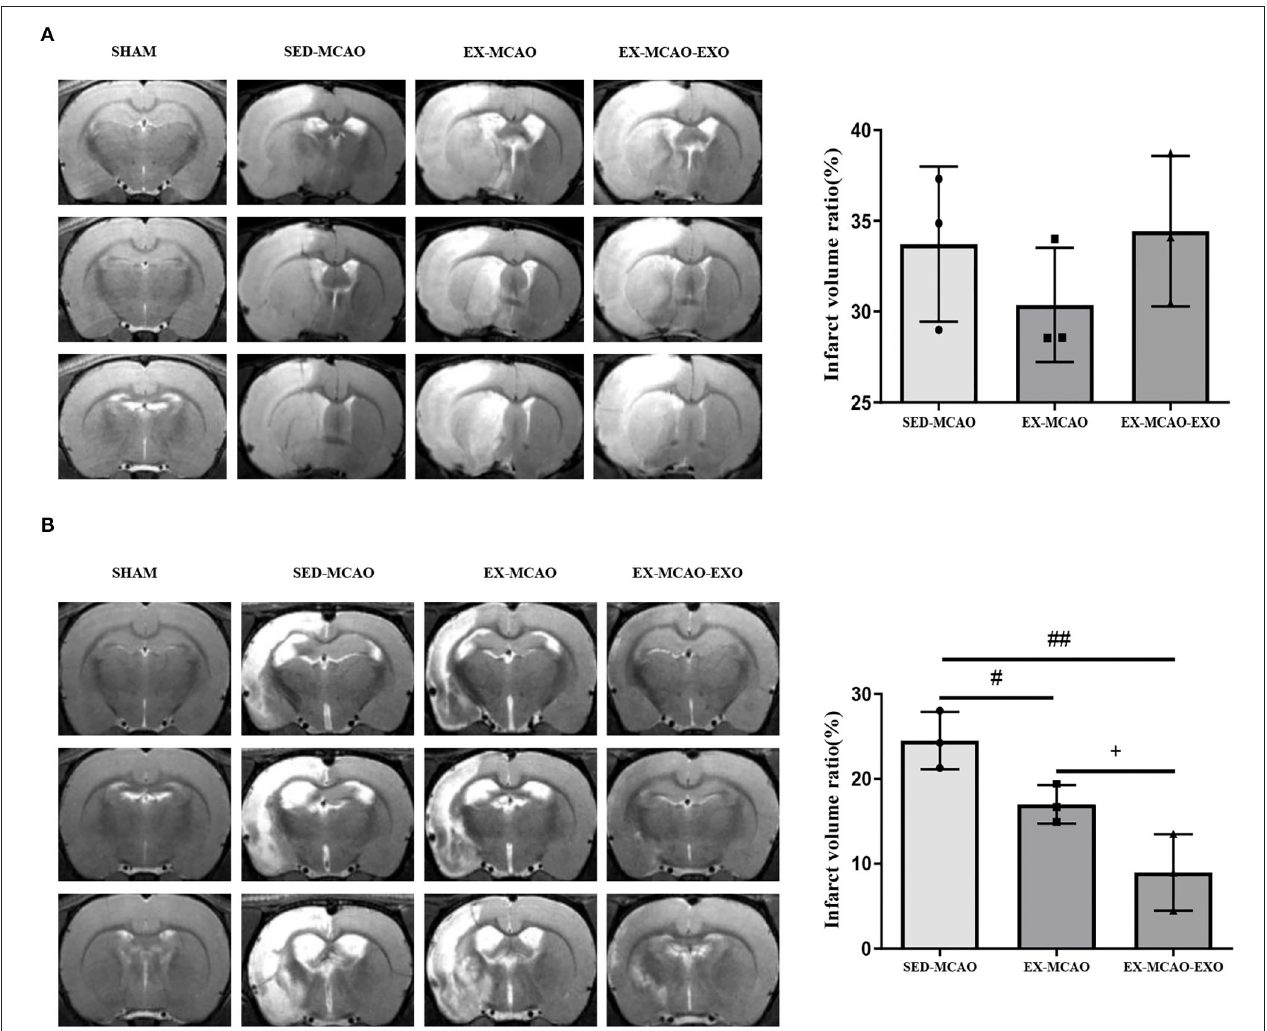
FIGURE 3 | Cerebral infarct volume ratio. (A) T2WI images of the rats and the cerebral infarct volume ratio in each group before intervention. (B) T2-WI images of the rats and the cerebral infarct volume ratio in each group after 28 days of intervention. # P < 0.05 and ## P < 0.01 compared with the SED-MCAO group; + P < 0.05 compared with the EX-MCAO group. Mean ± standard deviation. N =